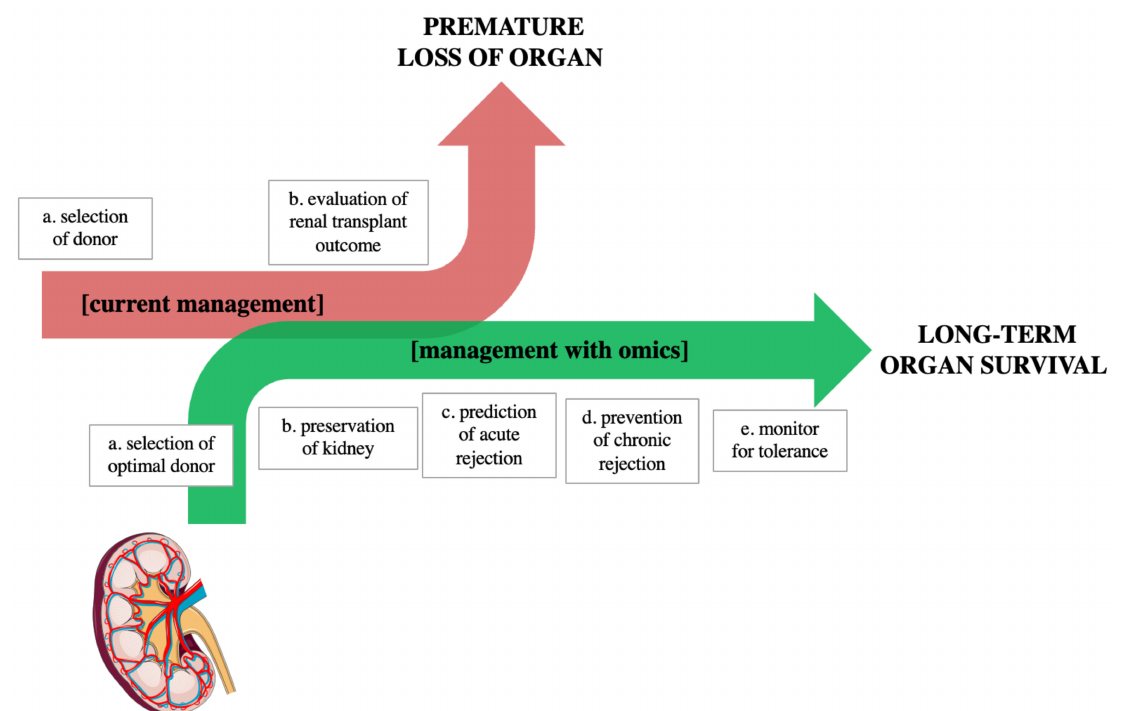
Figure 2. New perspective on renal transplant management. The arrows show the current manage- ment (red arrow) and future potential management (green arrow) adopted for kidney